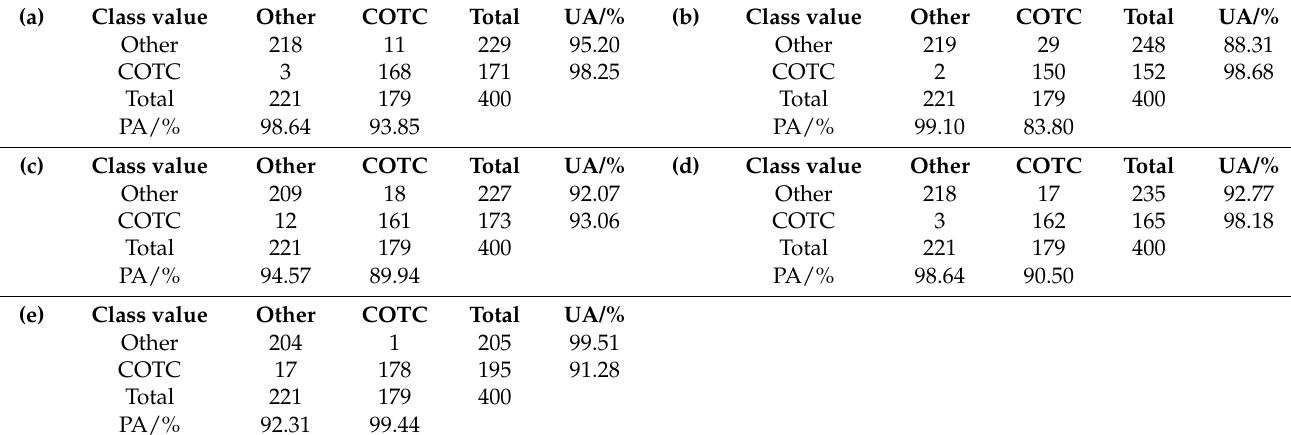
Table 5. Confusion matrix of extraction results of different